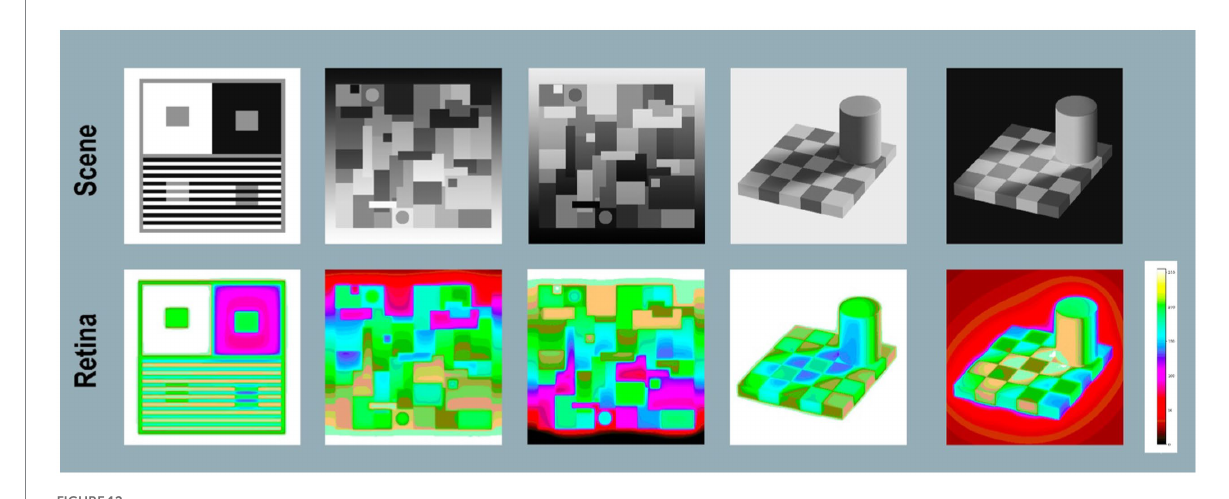
FIGURE 12 Glare’s Paradox-Scene: (top-row) shows Appearances of: Contrast, Mondrian [positive and negative], Checkershadow [positive and negative]. Retina:(bottom-row) pseudocolor rendering using [ cmap.LUT ]. On the far right is a plot retinal contrast digit value [0,255] vs. pseudocolor samples used to identify retinal _contrast_ log values. In total, this article calculates the retinal_contrast image for 9 Lightness illusion scenes. All 9 scenes contained GrayROI segments that showed Glare’s Paradox. In the 5 scenes that contained Assimilation Illusions, none of their pairs of GrayROI showed Glare’s